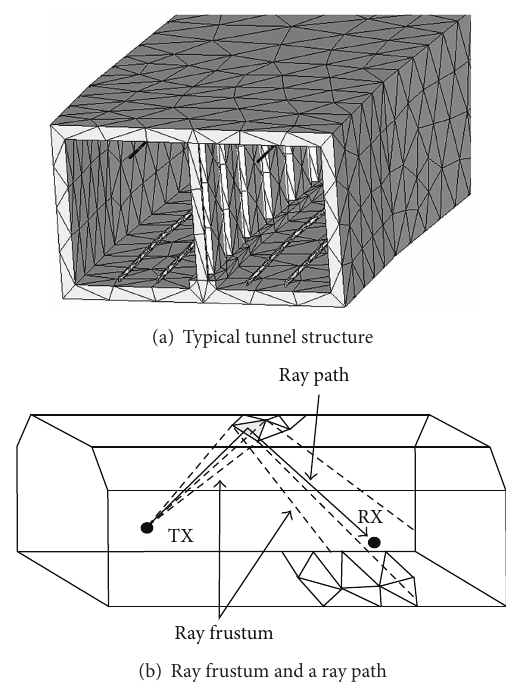
Figure 1: Triangulated tunnel structures and ray frustums to find a ray path to